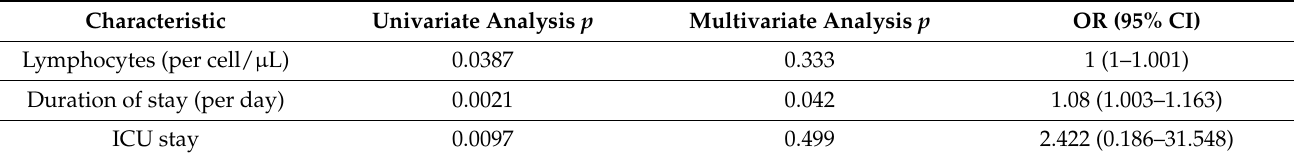
Table 3. Regression analysis of mortality.